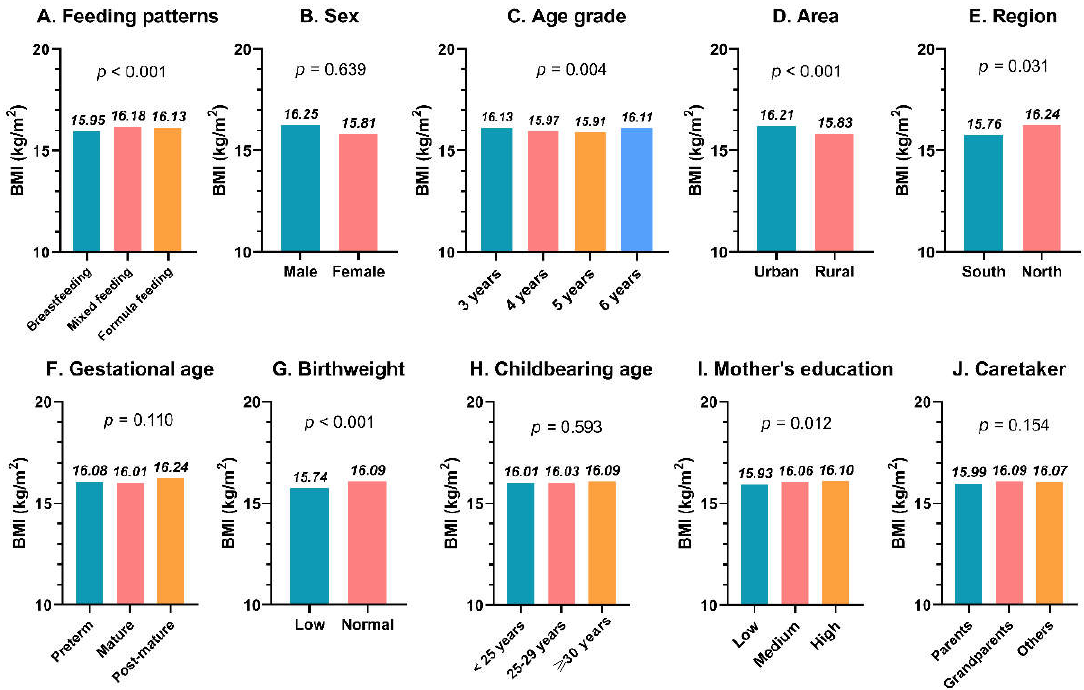
Figure 2. Mean distribution of BMI in subgroups. ( A ) Feeding patterns; ( B ) Sex; ( C ) Age grade; ( D ) Area; ( E ) Region; ( F ) Gestational age; ( G ) Birthweight; ( H ) Childbearing age; ( I ) Mother’s education; ( J ) Caretaker. Abbreviations: BMI, body mass index .